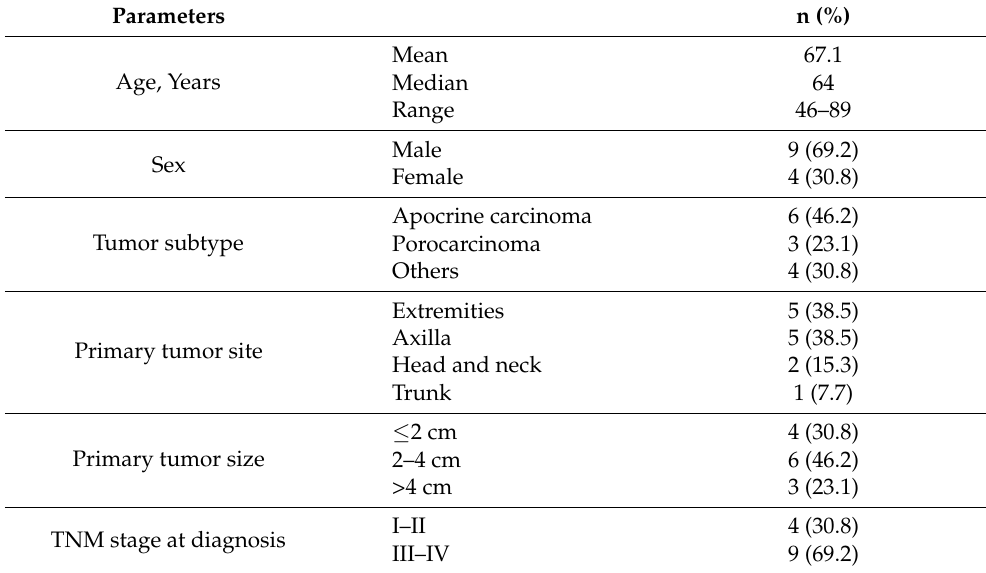
Table 2. Demographic data of 13 patients with sweat gland